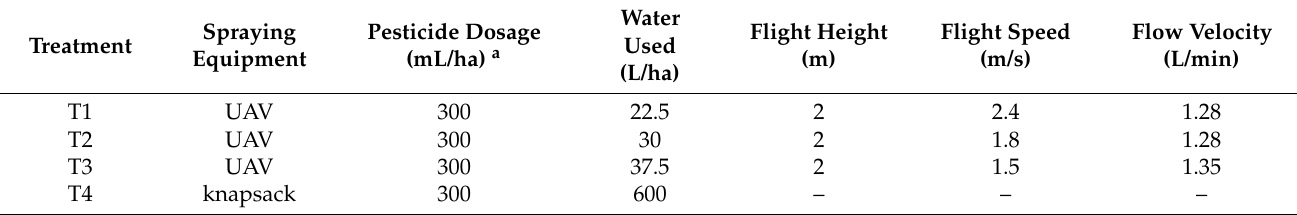
Table 1. The detailed working parameters of unmanned aerial vehicles (UAVs) and knapsack electric sprayers for field control against cowpea thrips.